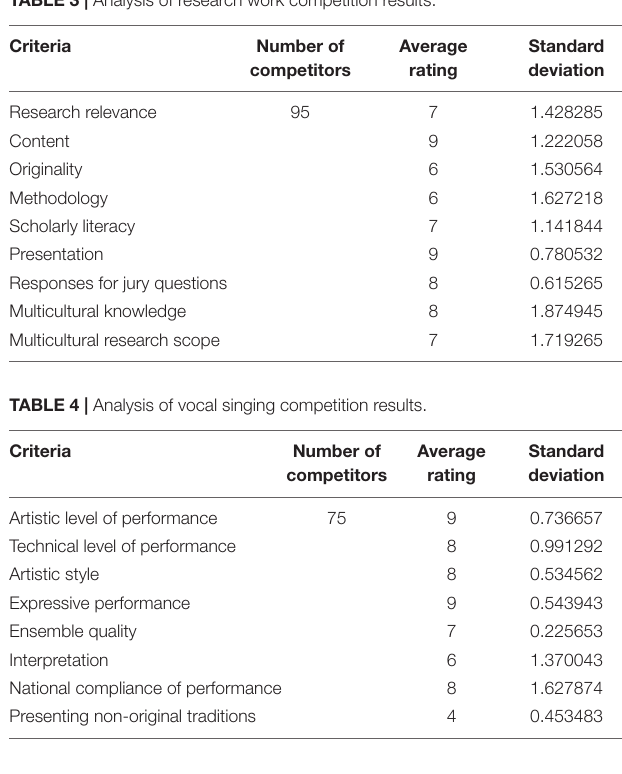
TABLE 3 | Analysis of research work competition results.